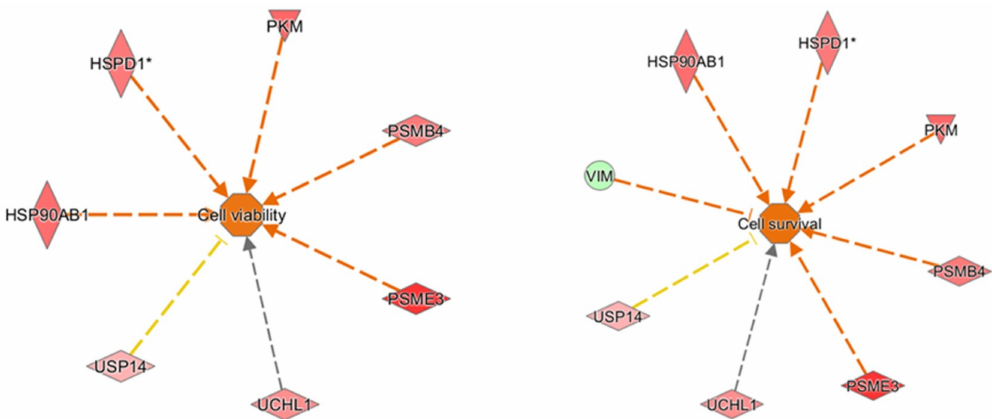
Figure 12. Downstream functions. Predicted activated functions based on up- (red) and down- (green) regulated proteins. Arrows predict a direct (orange) or indirect (grey) action on cell function. T bar predicts an inhibition on cell function. * This protein has been identified in many